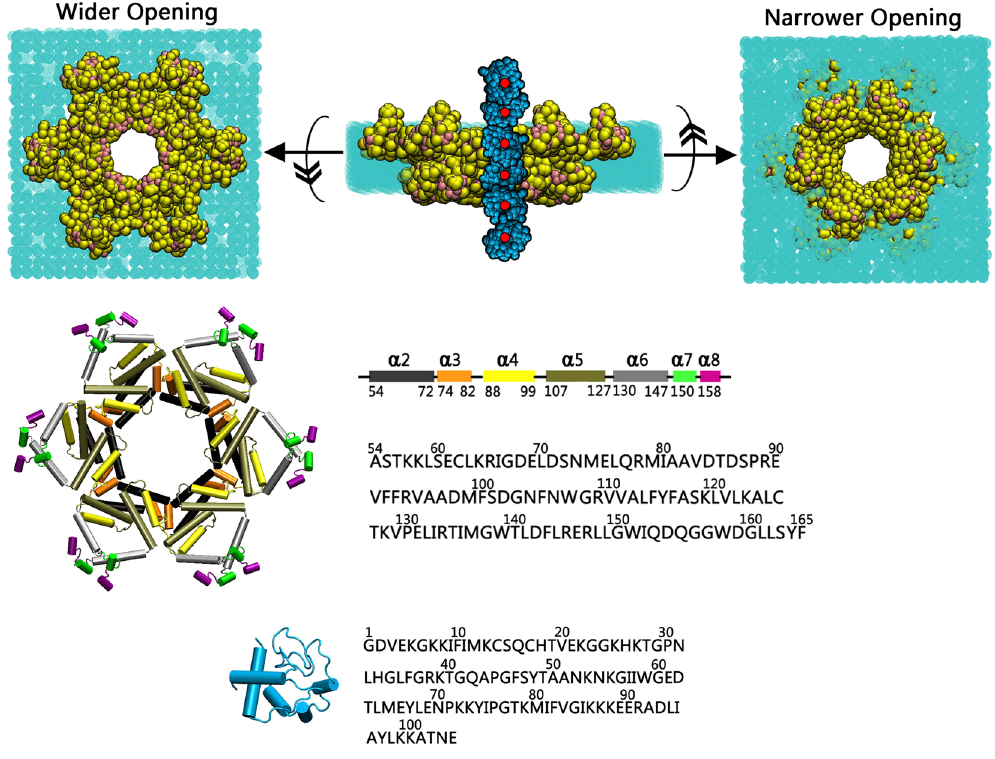
Figure 1. Snapshots of coarse-grained Bax oligomeric pores (yellow and pink) with the cytochrome C (cyan) at the membranes (green) (top); Secondary structures (Cartoon) and the amino acid sequences for Bax and cytochrome C